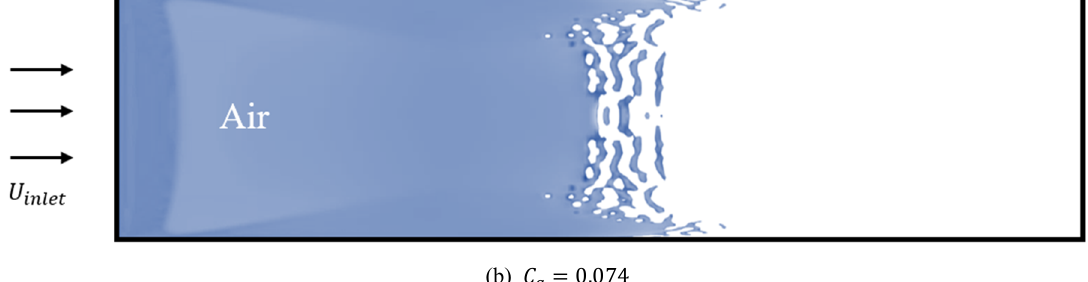
Figure 17. Air layer shapes at various injected air flow rates.